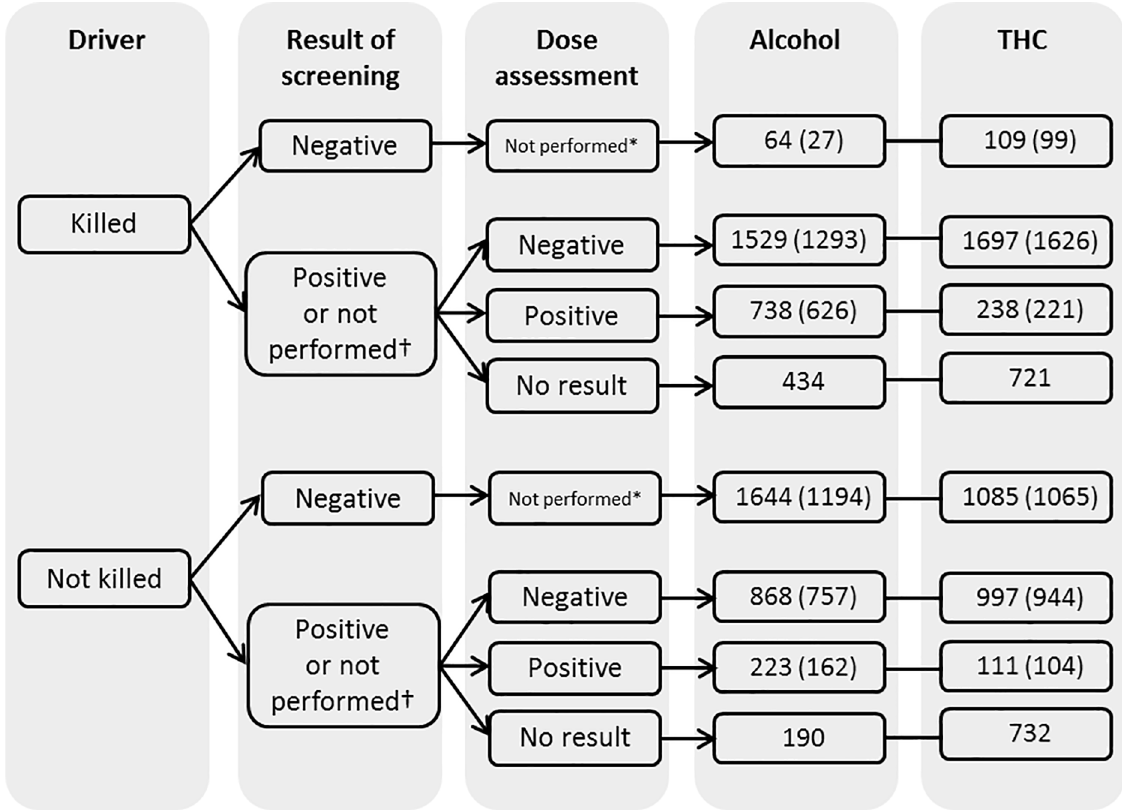
Fig 1. Screening and drug concentration measureprocess for drivers killed within 30 days after the crash or not. Numbers of drivers assessedpositive, negativeor with unknownstatus for alcoholand THC. * Dose assessment was not performed becausethe result of screeningwas negative.† Dose assessment was made in case of positive results of screeningor when screeningwas not performed.